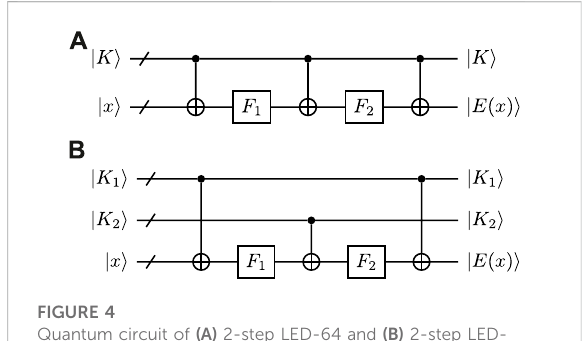
FIGURE 4 Quantum circuit of (A) 2-step LED-64 and (B) 2-step LED- 128, here ancilla qubits are not represented.